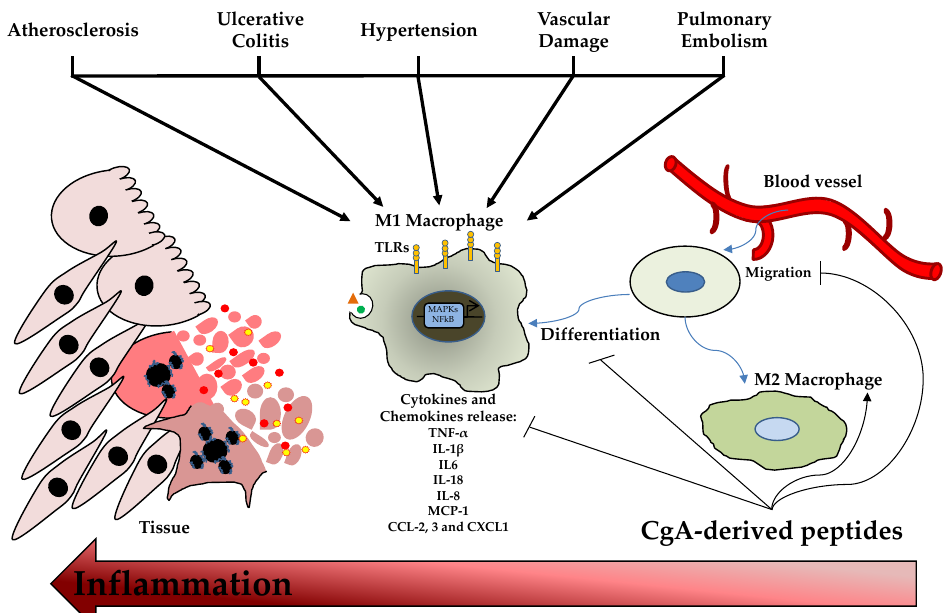
Figure 2. ChromgraninA ( CgA ) -derived Peptides and Inflammation . Damage or stress stimuli induce the migration, proliferation and activation of macrophages with consequent pro-inflammatory cytokines and chemokines release. This phenomenon generates cell death and inflammation. CgA-derived peptides can reduce M1 polarization and promote M2 anti-inflammatory macrophages differentiation. C-C motif chemokine ligand (CCL); C-X-C motif chemokine ligand (CXCL); interleukin (IL); monocyte chemoattractant protein (MCP); toll-like receptor (TLR); tumor necrosis factor (TNF).